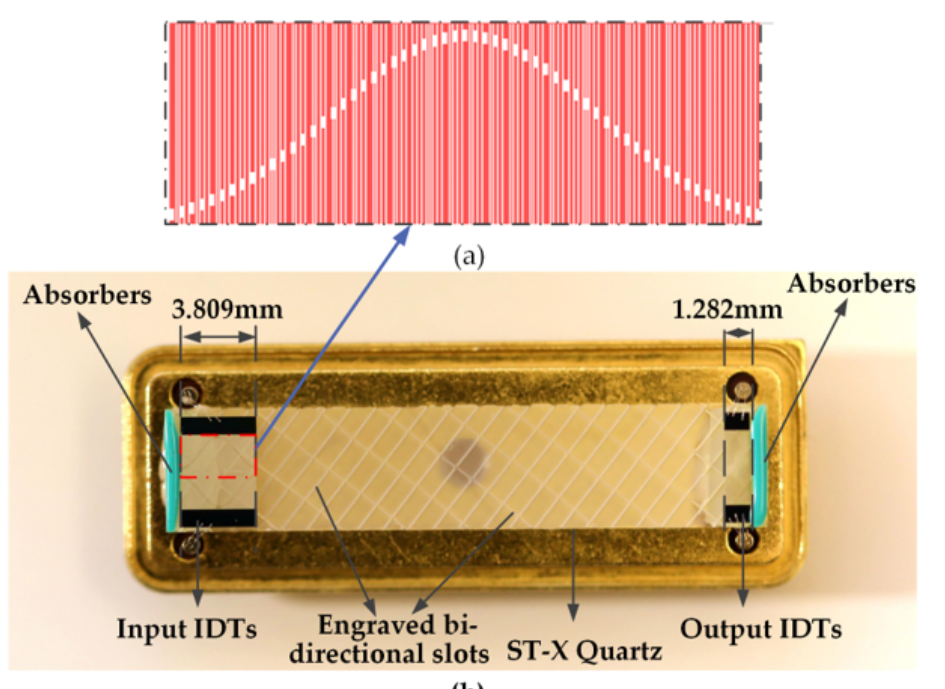
Figure 4. Surface acoustic wave devices fabricated on ST-X Quartz substrates. ( a ) unbalanced-split electrode ( b ) image of SAW devices.